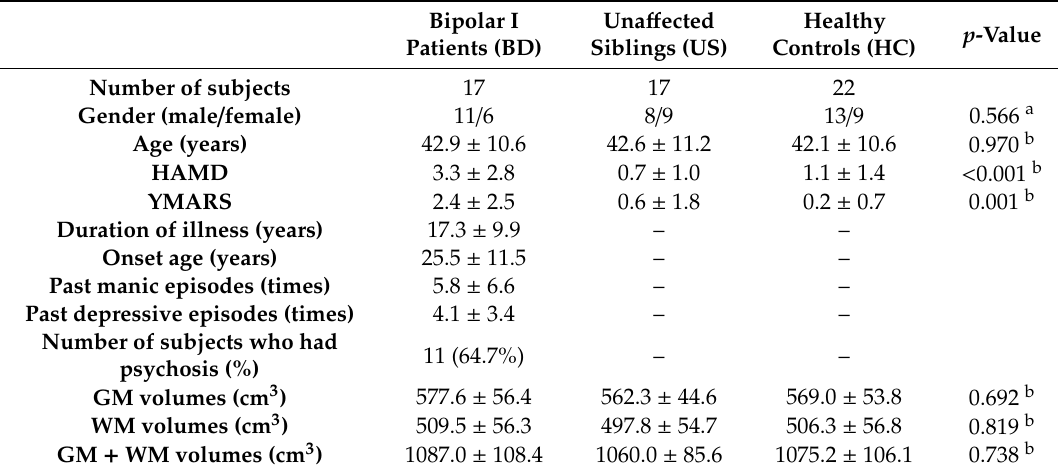
Table 1. Demographic and clinical details of study